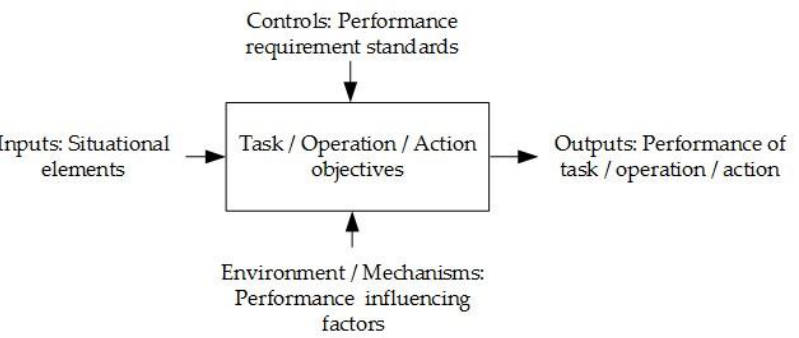
Figure 3. A functional block in a hierarchical task analysis and structured analysis and design technique (HTA-SADT) diagram.